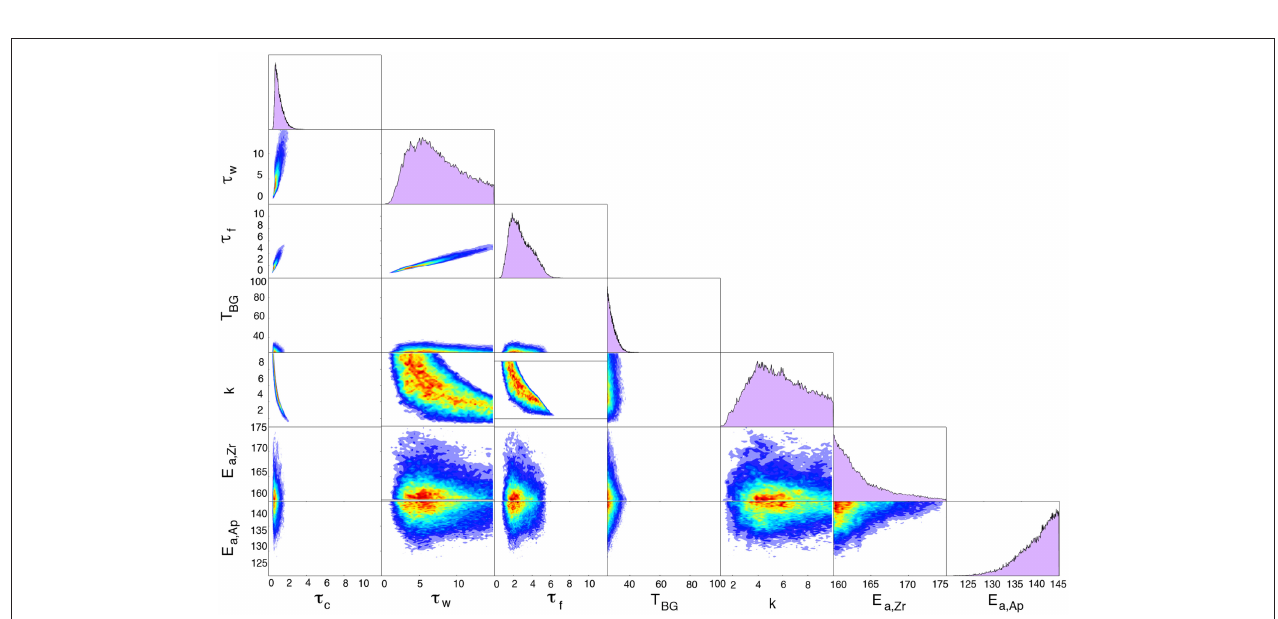
FIGURE 9 | MCMC marginal posterior PDFs as in Figure 8 and bivariate covariance plots for the Maxwell Lake dike. T BG , τ c , τ w , k , E a , Ap , E a , Zr are estimated parameters, while total flow duration τ f is derived using Equation (11). Covariance plots show how parameters trade off with one another within the posterior PDF, warmer colors indicate higher probability.